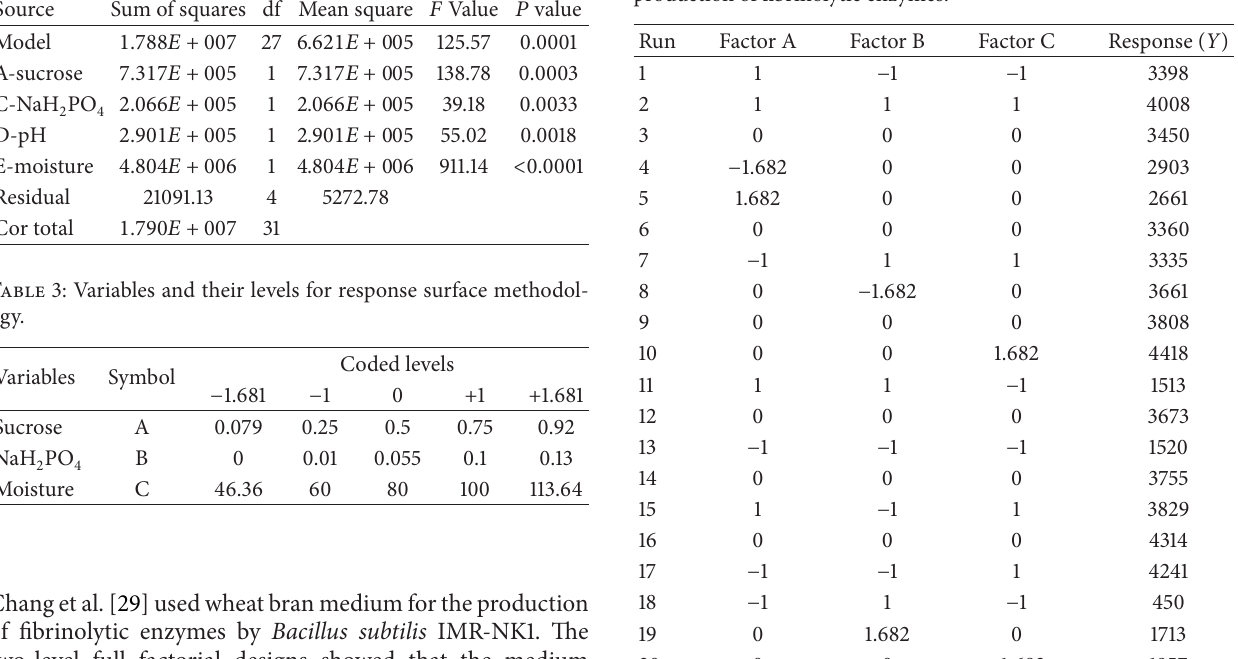
Table 4: Central composite designs matrix and results on the production of fibrinolytic